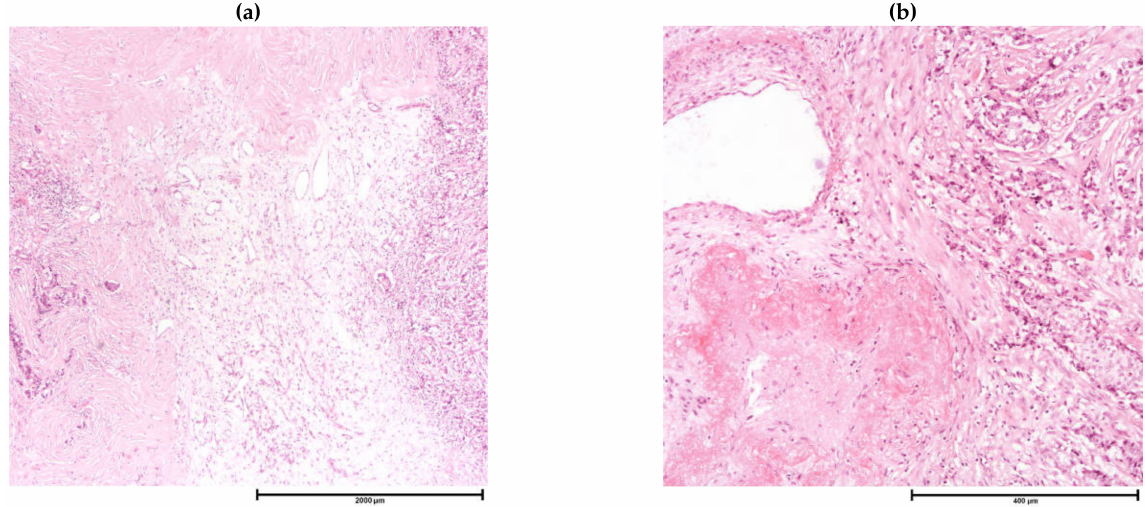
Figure 3. Fibrotic Foci on H&E Sections. ( a ) H&E, 20 × ; ( b ) H&E, 100 ×